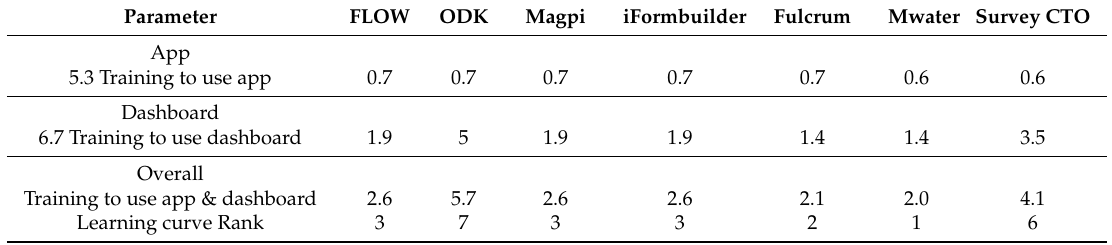
Table 14. Learning curve (estimated hours to learn to proficiently use MST (average of four